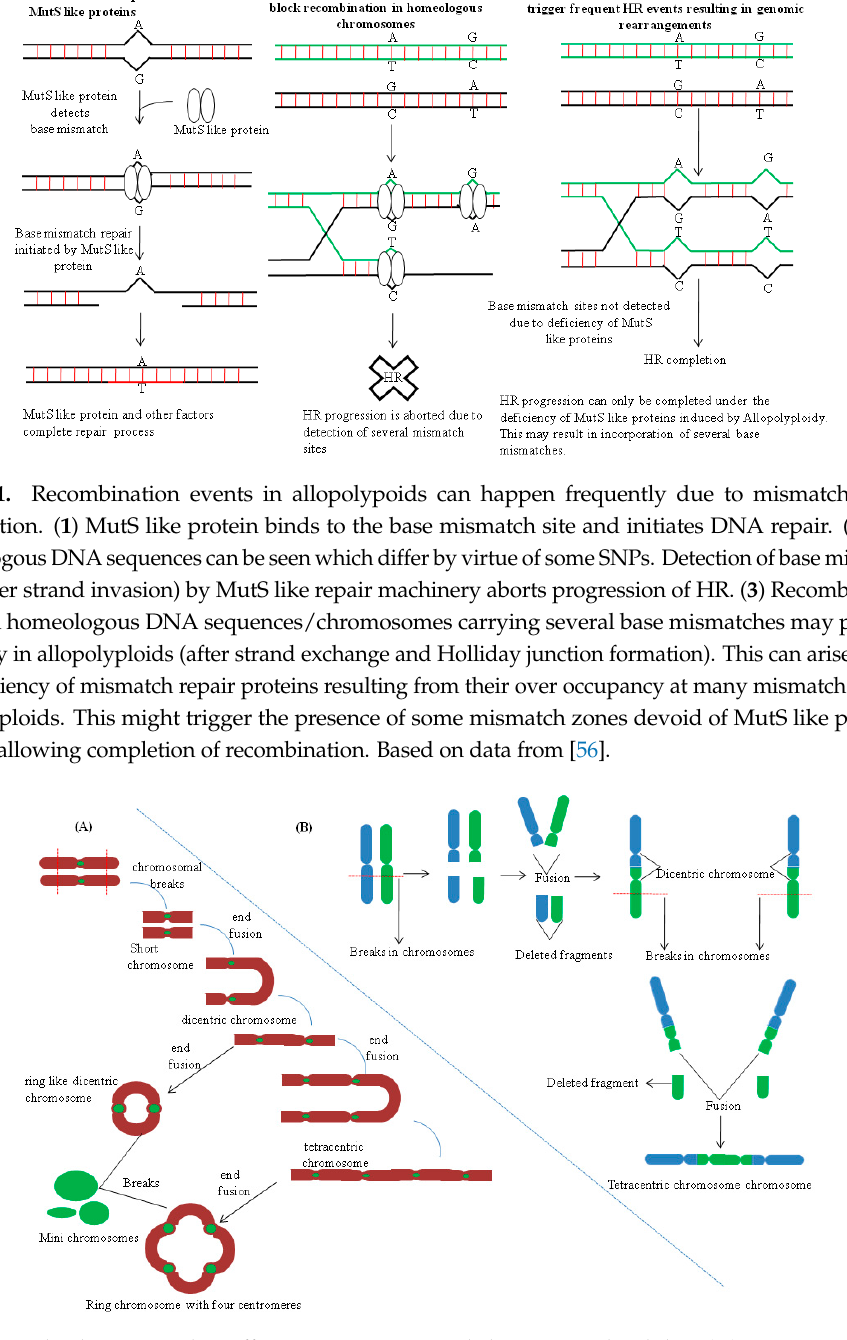
Figure 2. Hybridization and its effect on centromere and chromosomal stability. ( A ) Formation of ring like chromosomes and mini chromosomes with multiple centromeres. ( B ) Formation of dicentric and multicentric chromosomes in progenies of wheat rye hybrids. Based on data from [59].